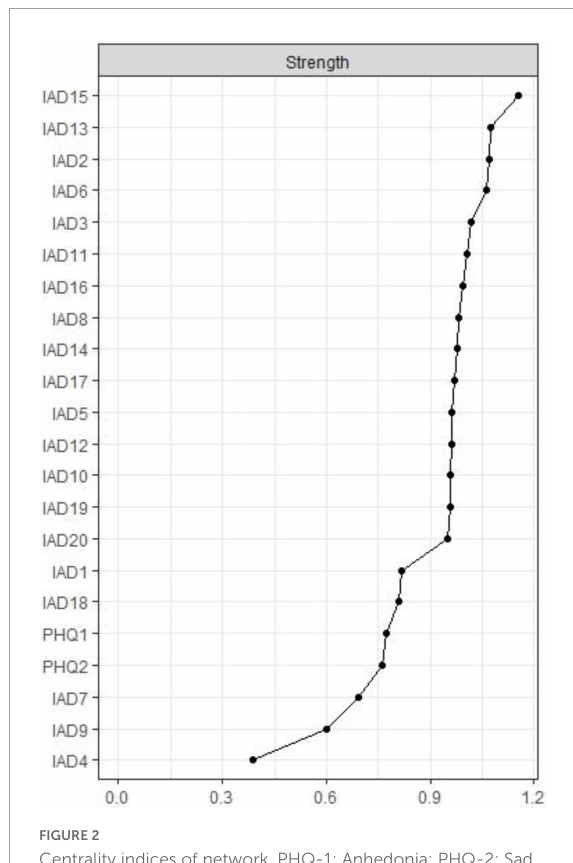
FIGURE2 Centrality indices of network. PHQ-1: Anhedonia; PHQ-2: Sad